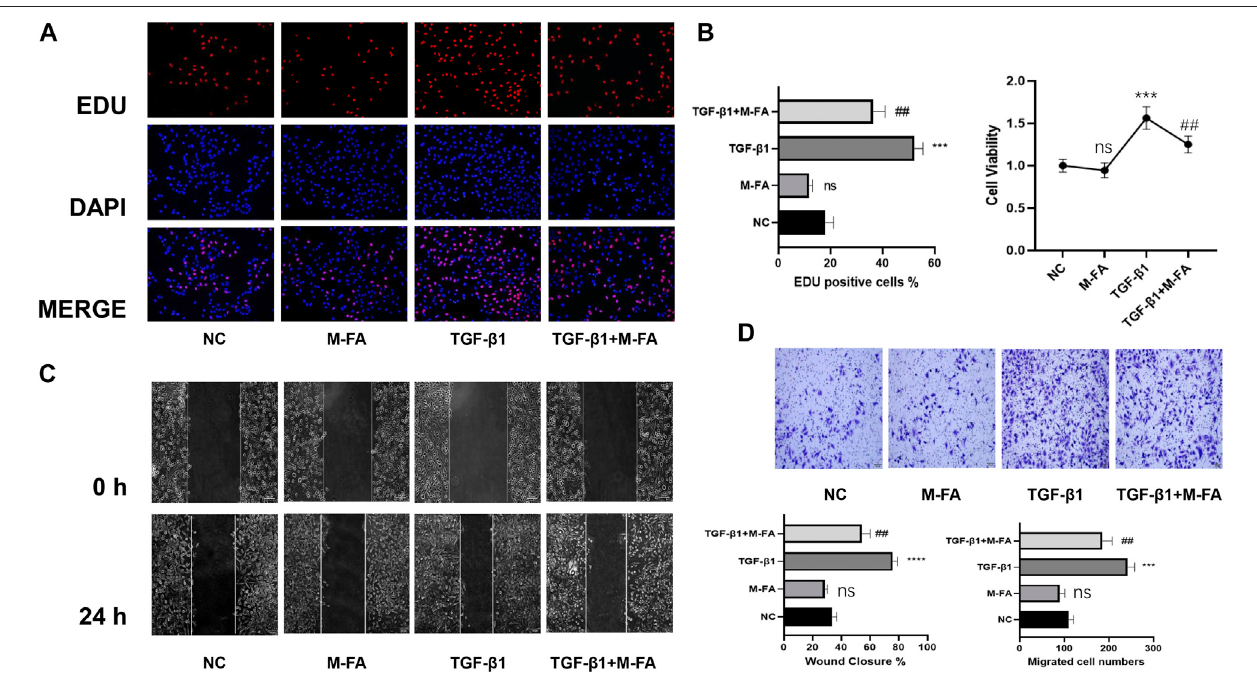
FIGURE2| MFAsuppressed proliferationandmigrationabilityinTGF- β 1 – stimulatedHCFs. (A – B) EDUassay(A)andCCK-8assay(B)wereperformedtoevaluate theproliferationabilityofHCFs( n (cid:2) 6). (C – D) Woundhealingassay(C)andTranswellassay(D)wereperformedtoevaluatethemigrationabilityofHCFstreatedasbelow ( n (cid:2) 6). (*compared with negative control: *** p < 0.005, **** p < 0.001. # Compared with the TGF- β 1 group: # p < 0.05, ## p < 0.01).